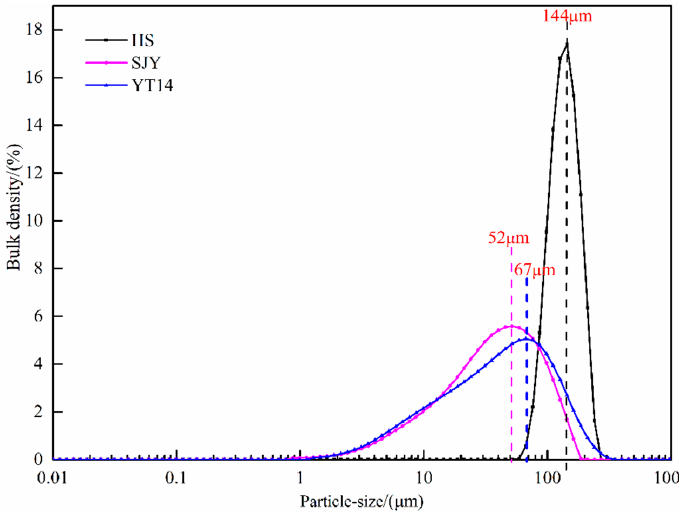
Figure 3. Particle size distribution of the experimental raw materials. By using the NOVA-1200e specific surface area analyzer (NOVA-1200e; Quantachrome, Boynton Beach, FL, USA) and nitrogen adsorption Brunner − Em- met − Teller (BET) method, the specific surface area of the three raw materials used in the experiment was determined and analyzed to further characterize the surface condition of